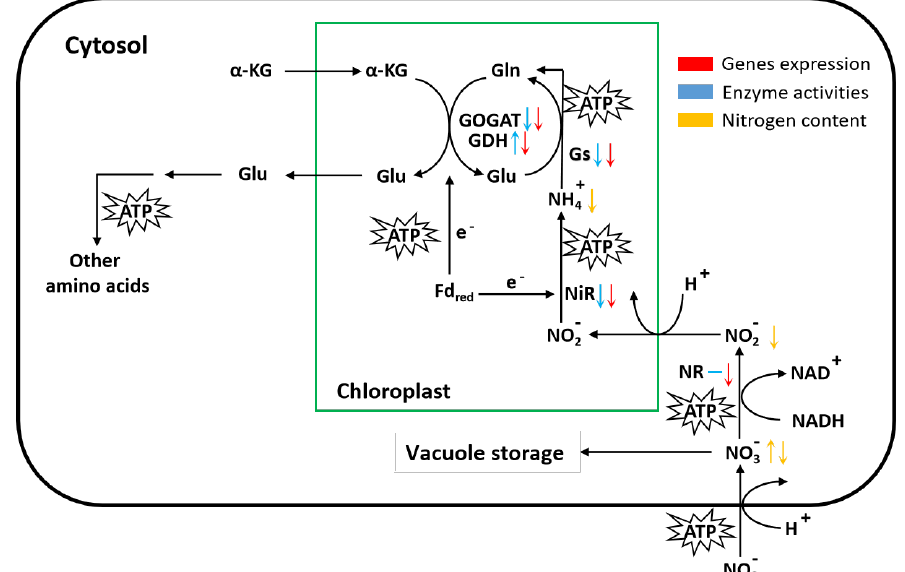
Figure 3. Influence of high CO 2 concentration on nitrogen metabolism regulation in Masson pine needles. Biosynthesis pathways according to Taiz [56]. The green and black rectangles represent the chloroplast and cytosol, respectively. The gene expression, enzyme activities and the content of di ff erent nitrogen forms are shown in red, blue and orange, respectively. Up- and downward-facing arrows indicate up- and downregulated expression, respectively. The blue line in NR indicates that there is no di ff erence in the enzyme activity expression of NR, and the specific data are shown in Figure 1B. α -KG, α -Ketoglutaric acid; Fdred, Reduced ferredoxin.